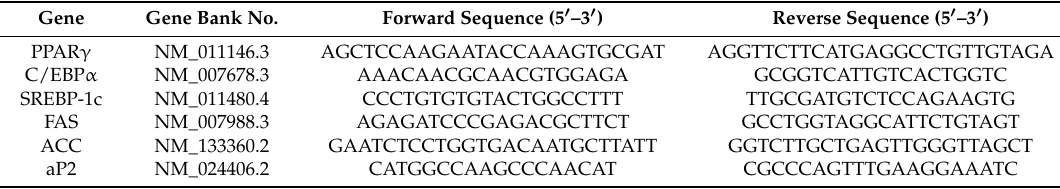
Table 1. Primers used for Real-Time Quantitative Polymerase Chain Reaction